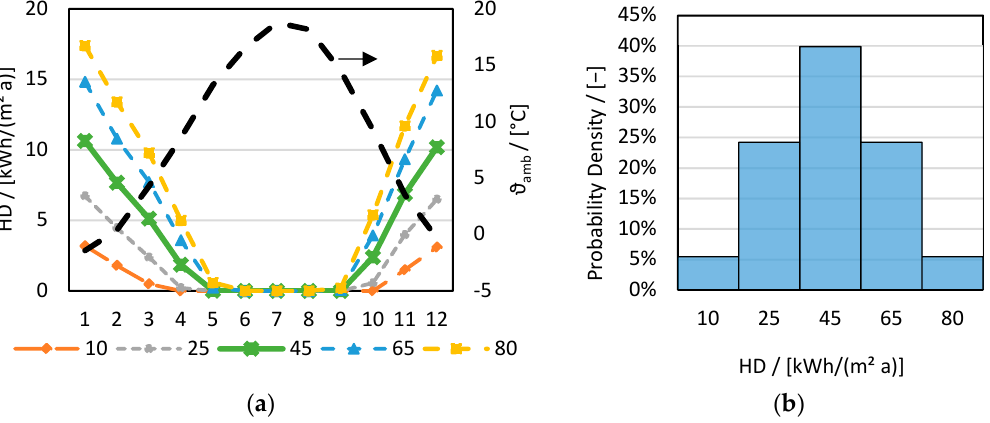
Figure 7. ( a ) Monthly space heating demand (HD) of the building with different qualities of the envelope (acc. to Table 3), considering the climate of Innsbruck [30]; ( b ) normal distribution of the space HD of the buildings in the considered DH system.